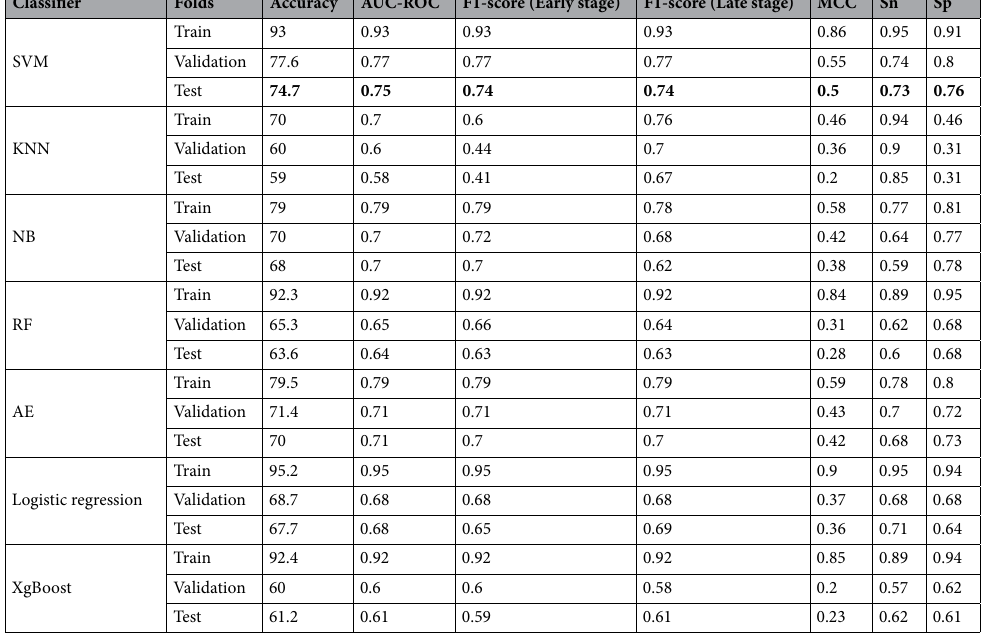
Table 2. The performance of classifiers based on 123 selected mRNAs. Significant values are in bold. AUC: The area under the curve, ROC: receiver operating characteristic curve, MCC: Matthews Correlation Coefficient, Sn: sensitivity, Sp: